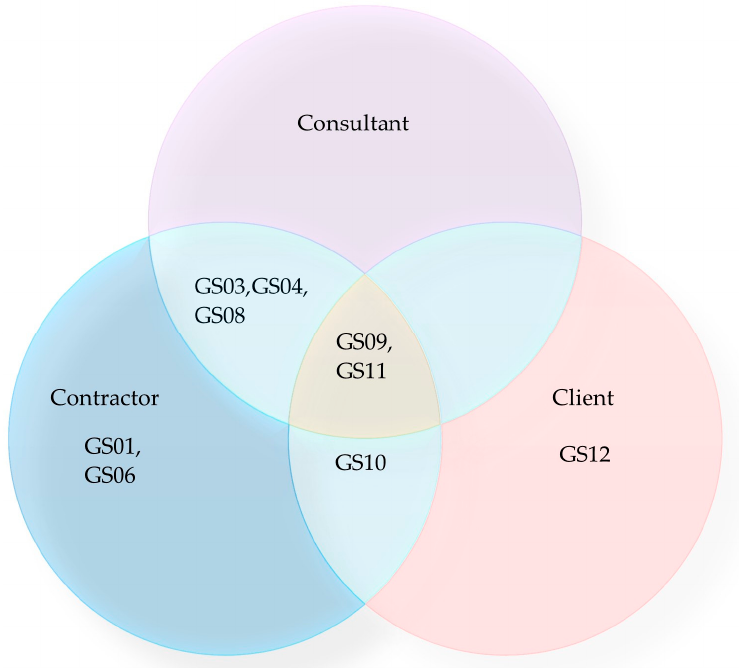
Figure 1. Overlapping critical government strategies between stakeholders.